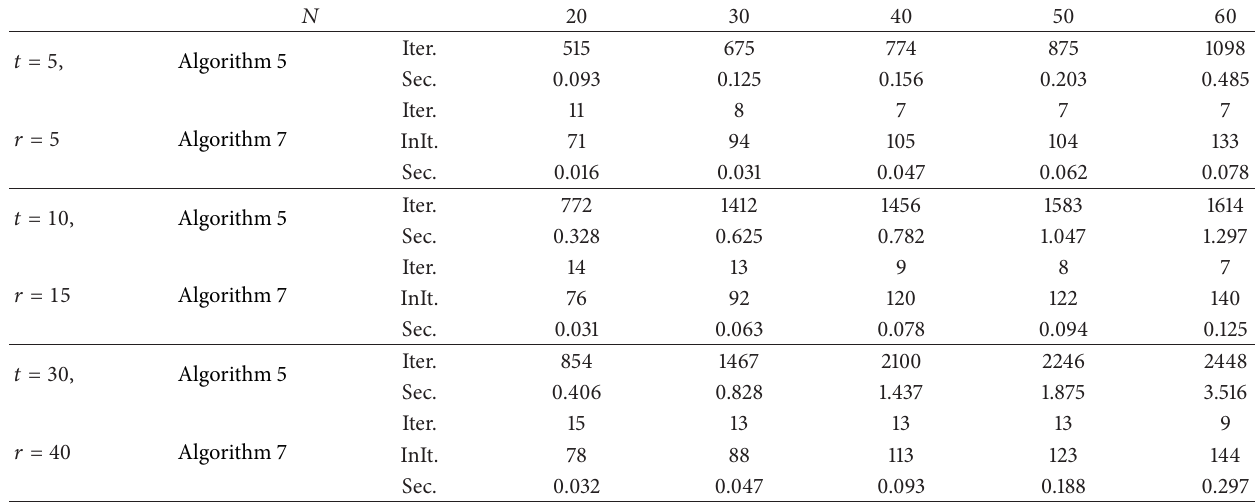
Table 2: Computational results for Example 14 with different dimensions and different numbers of 𝐶 𝑖 and 𝑄 𝑗